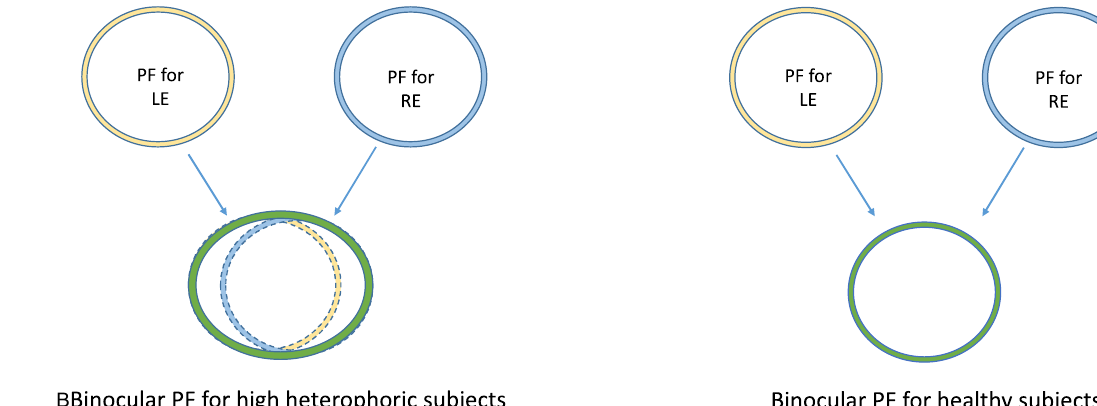
Figure 4. Illustration of a model explaining the larger binocular PF’s size for the horizontal meridian for subjects presenting a high heterophoria in comparison to healthy